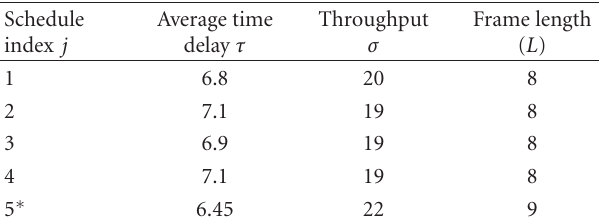
Table 4: Performance characteristics of M 1